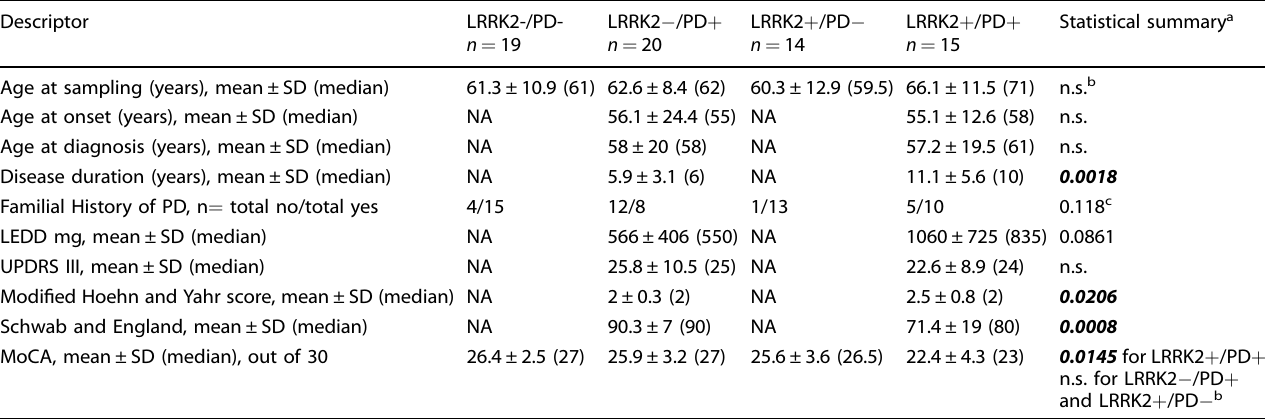
Table 1. Overview of values for key clinical parameters of samples from the LRRK2 cohort consortium: age at sampling, age at onset, age at diagnosis, disease duration, familial history (y/n), Levodopa Equivalent Daily Dose (LEDD), Uni fi ed Parkinson ’ s disease rating scale III (UPDRS III), modi fi ed Hoehn and Yahr Stage, Modi fi ed Schwab and England Consensus Rating, Montreal Cognitive Assessment